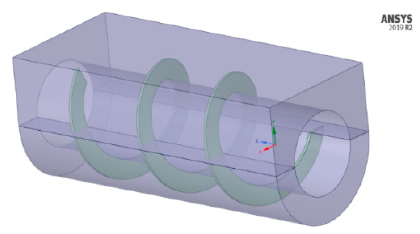
Figure 6. 1/6 partial model of screw-type dryer.